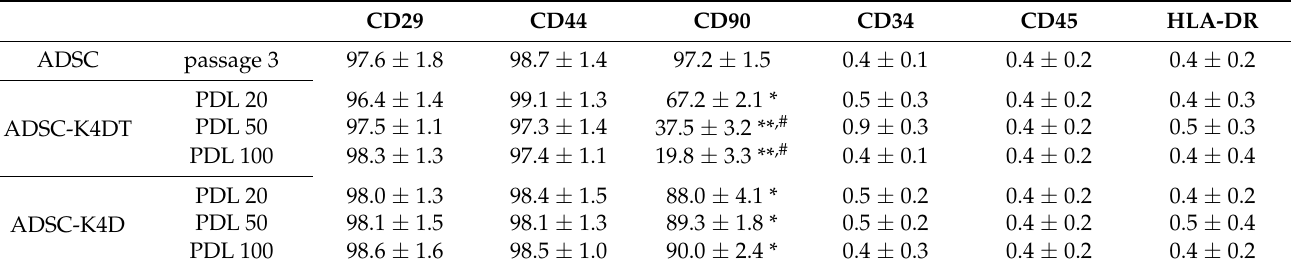
Table 1. Flow cytometric analysis of cell surface markers.